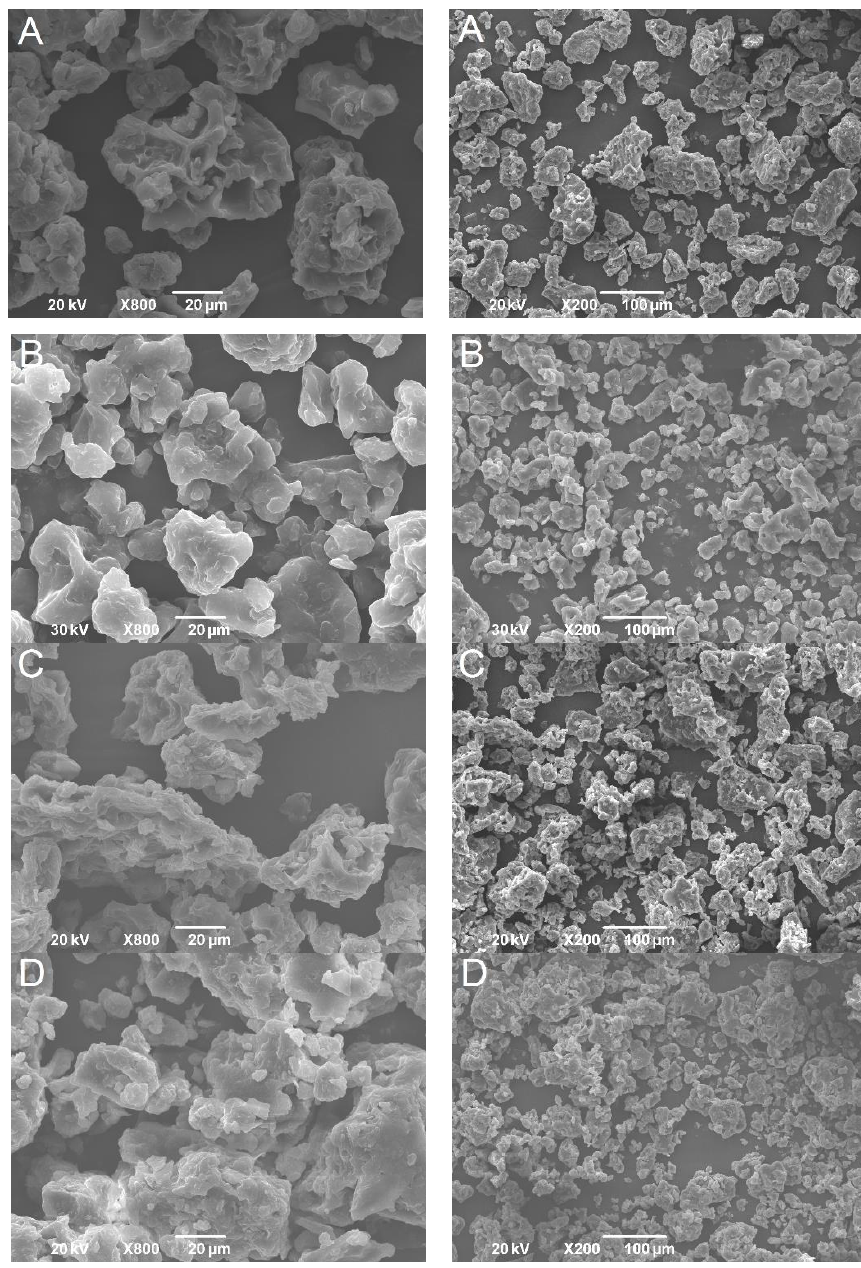
Figure 3. SEM pictures of solid lipid microparticles (formulation ( A )-first row; formulation ( B )-second row; formulation ( C )-third row; formulation ( D )-fourth row).